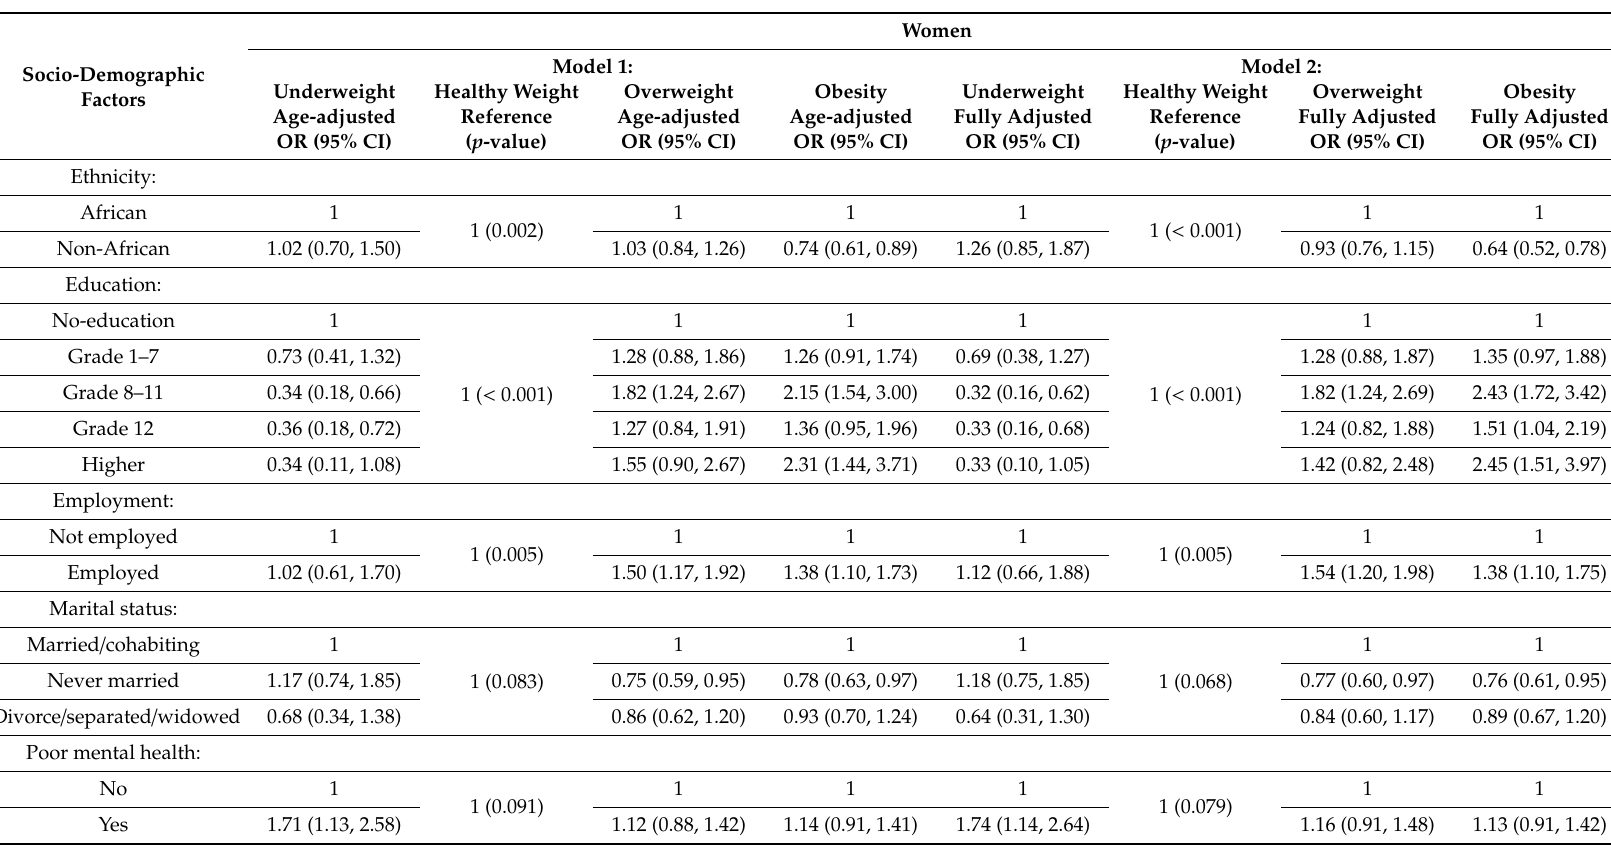
Table 5. Relative risk of underweight, overweight and obesity among 3104 women from the SANHANES study in 2012; by indicators of socioeconomic position (minimally and fully adjusted odds ratios from multinomial